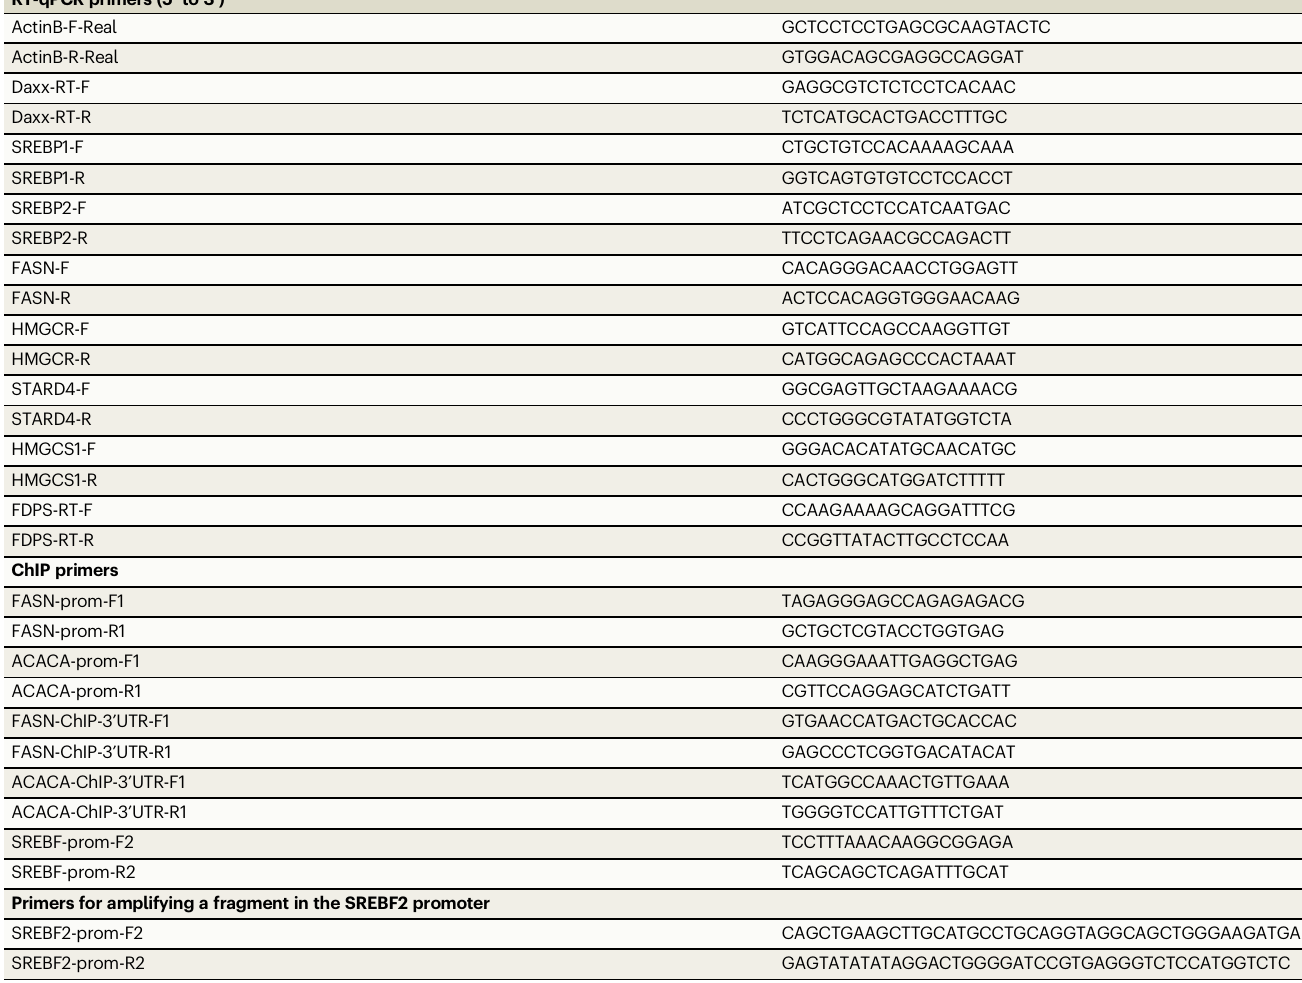
Table 1 | PCR primers used for this study RT-qPCR primers (5 ’ to 3 ’